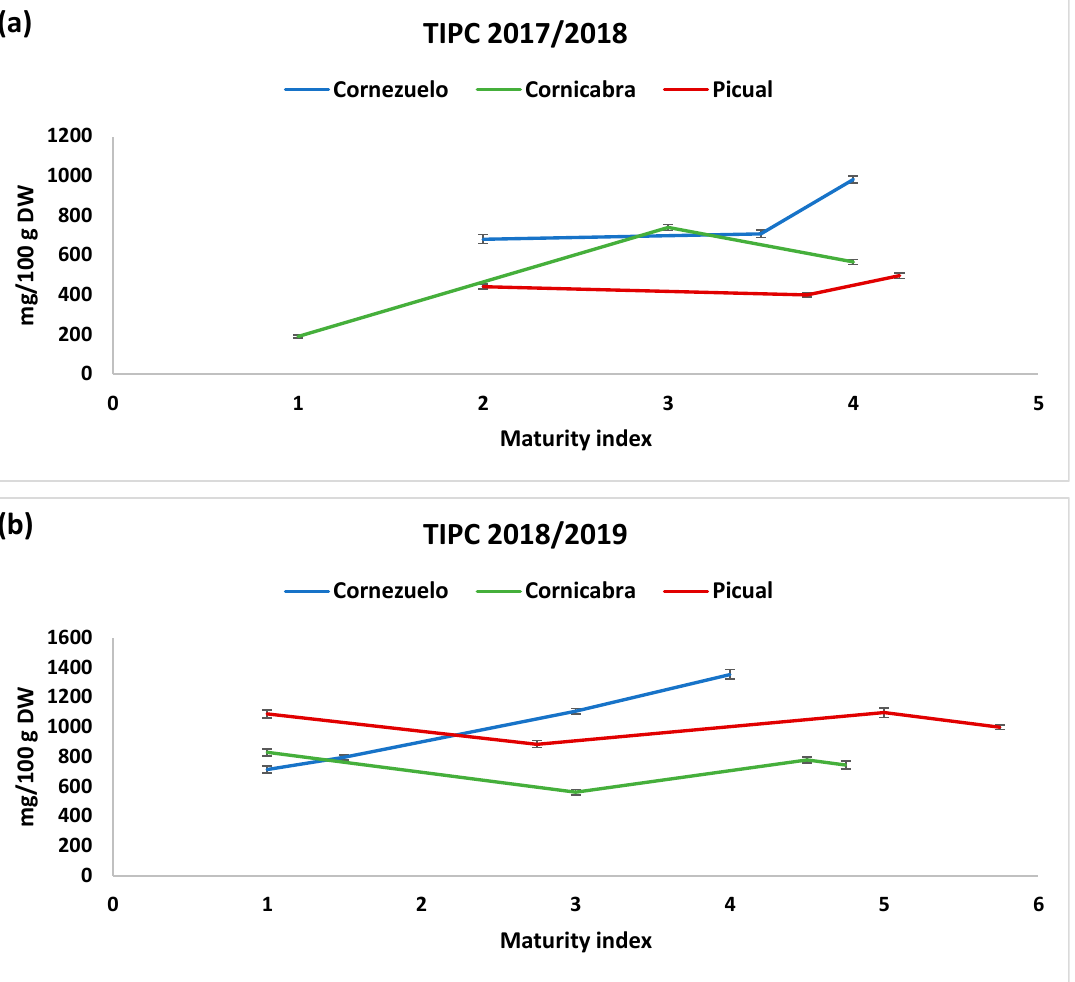
Figure 5. TIPC of the three varieties of olive fruits in the different collection months during seasons 2017/2018 ( a ) and 2018/2019 ( b ). Values (mg/100 g dry weight) are mean ± SD of three parallel measurements.